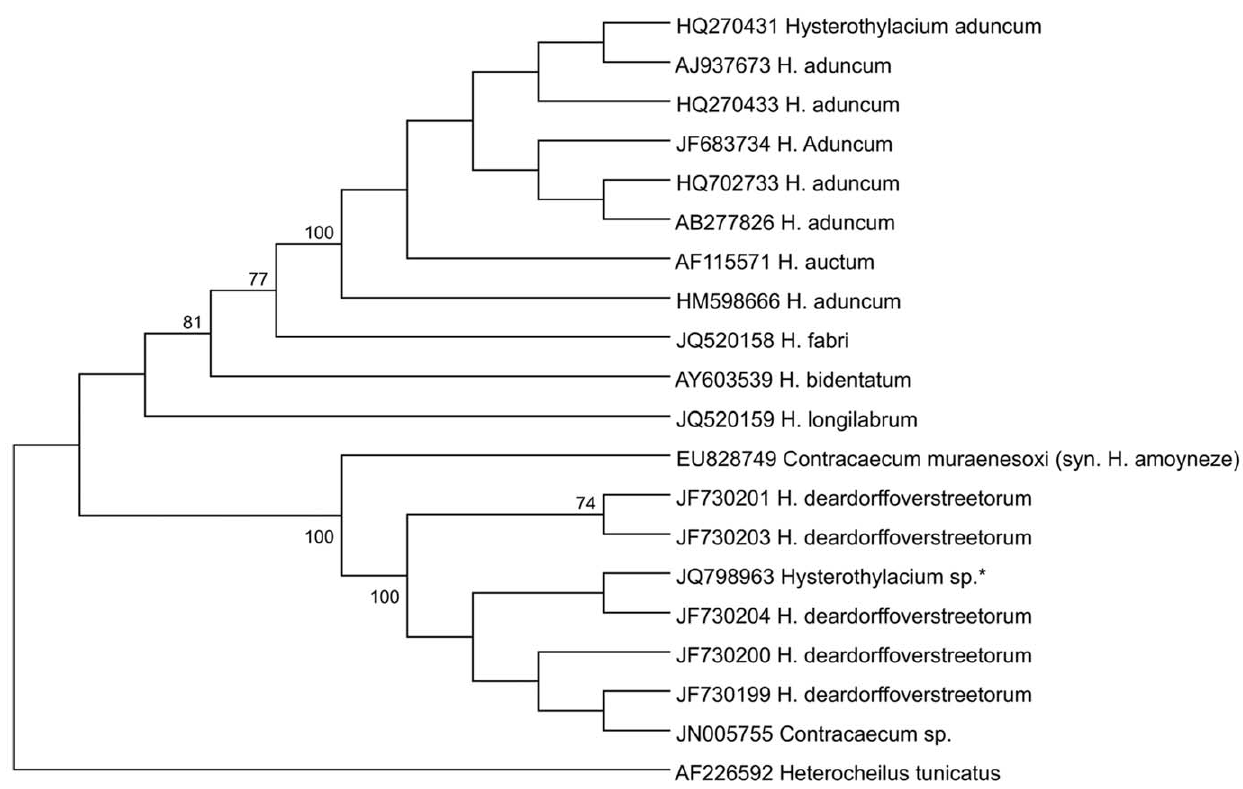
Figure 8. Maximum likelihood reconstruction between sequences of Hysterothylacium sp. larvae obtained in this study (*) and sequences of other anisakid species from the GenBank inferred from the ITS dataset. The numbers on the tree branches represent the percentage of bootstrap resampling. Heterocheilus tunicatus was used as an out group.